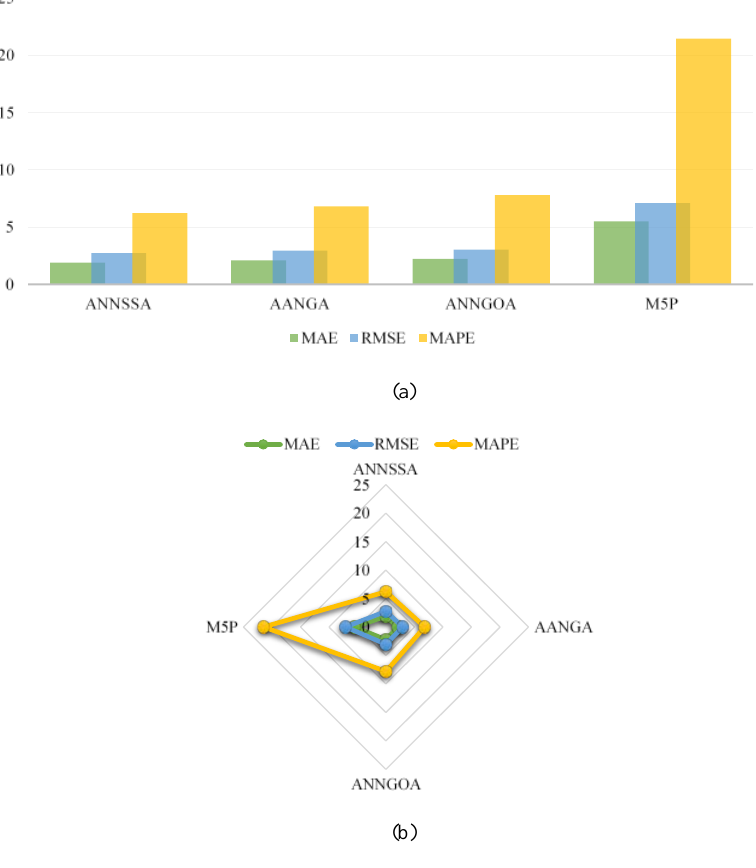
Figure 8. ( a ) A bar chart and ( b ) a radar chart to compare models’ results